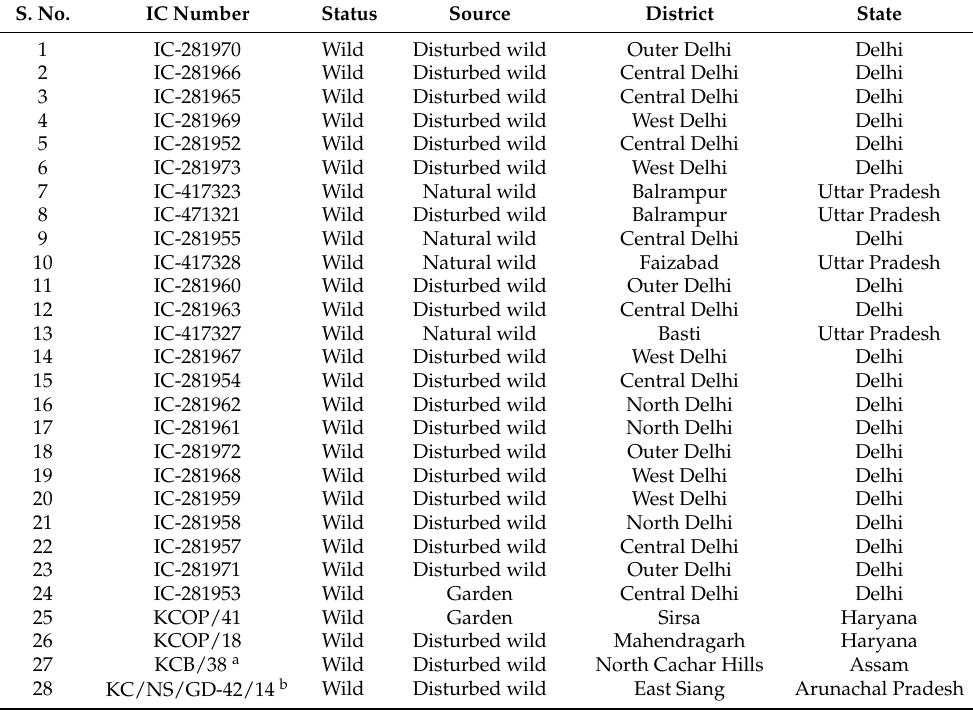
Table 1. Details of Tinospora accessions used in genetic diversity study. S.